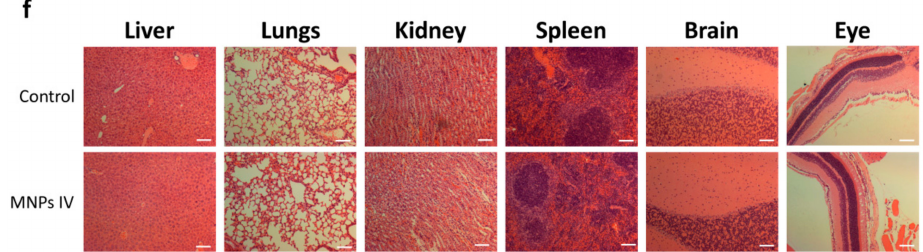
Figure 7. ( a ) A schematic drawing to illustrate in vivo magnetic targeting with intravenous injection; ( b ) Fluorescent and BF images by Maestro imaging of extracted retinas: untreated retina (left), retina close to an external magnet (middle) and retina opposite to magnet side (right); ( c ) Quantitative analysis of fluorescence image shown in ( b ); ( d ) Light microscopy image showing the Prussian blue iron staining followed by counterstaining with nuclear fast red of targeted eye. Scale bar = 100 µ m; ( e ) Biodistribution of particles in mice after magnetic targeting. Inductively coupled plasma (ICP) quantification of iron in organs collected from three test groups: untreated control mice, injected mice and magnet targeted injected mice; ( f ) Images of H&E stained organs collected from control and MNPs injected mice 18 days after